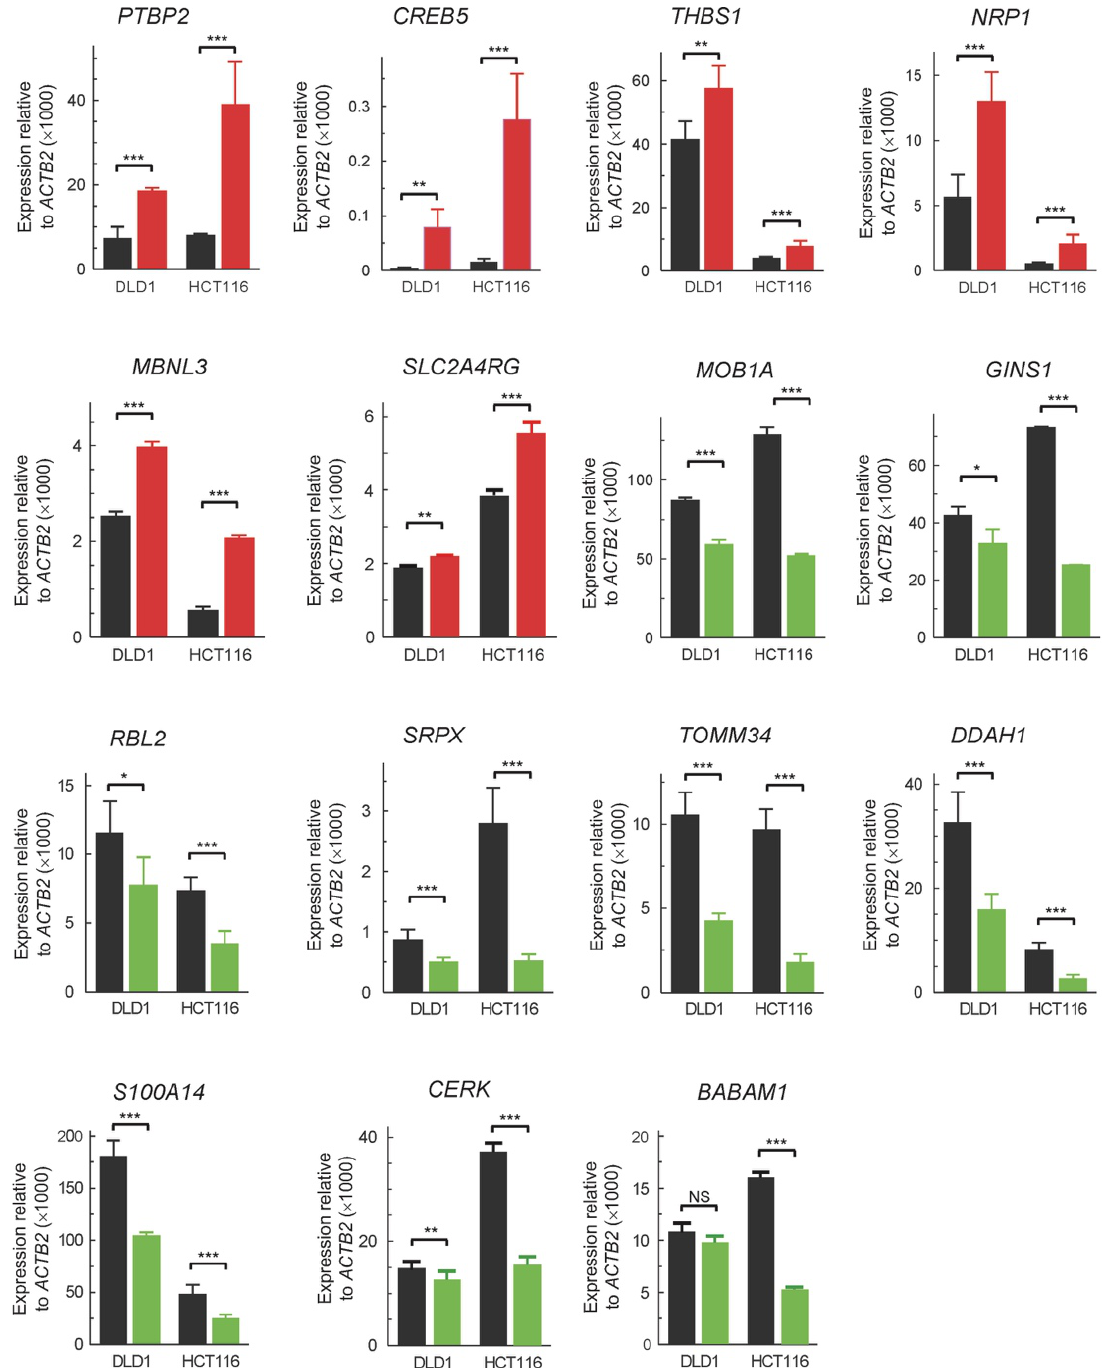
Figure 3. RT-qPCR validation of the changes in expression in some genes selected among those detected as affected by silencing ZNF518B in the Clariom-S analysis (see Supplementary Tables S2 and S3). The analysis was done in both DLD1 and HCT116 cells. The black bars correspond to control cells, transfected with scrambled siRNA, while the coloured bars depict the results obtained with cells transfected with si- ZNF518B. *, p < 0.05; **, p < 0.01; ***, p < 0.001; NS, non-significant.